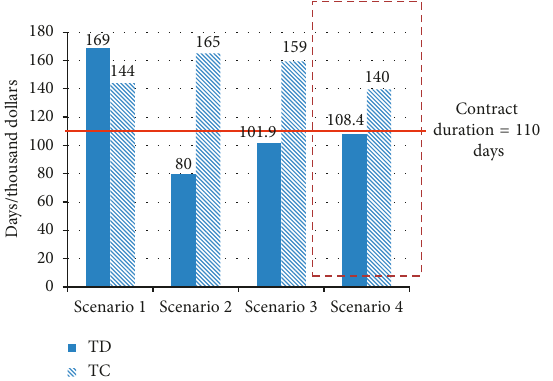
Figure 7: Comparison of four overlapping